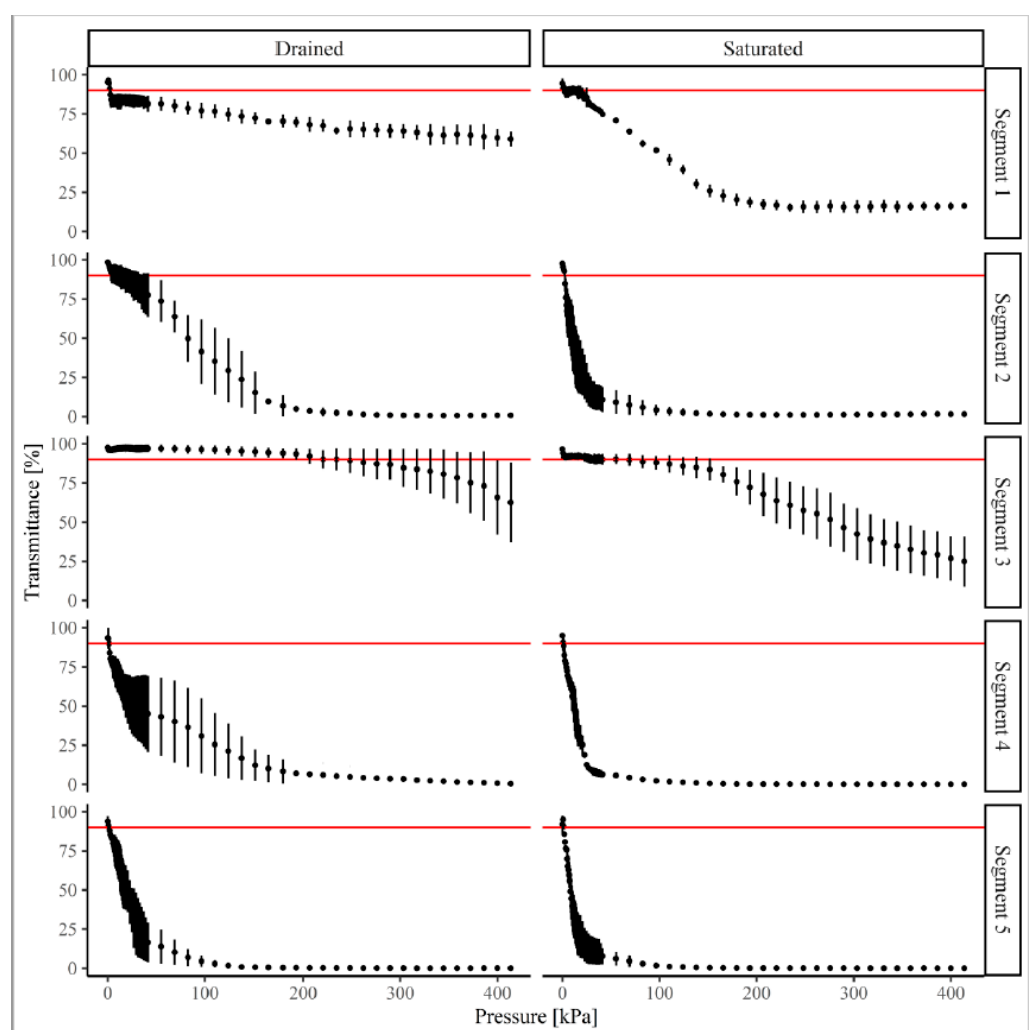
Figure 5. Light transmittance values as a function of internal CSM pressure (P i ). The vertical lines in the graphs indicate standard deviation and the dots are average light transmittance values ( n = 3). The red lines at 90% transmittance represent the threshold for initiation of erosion.